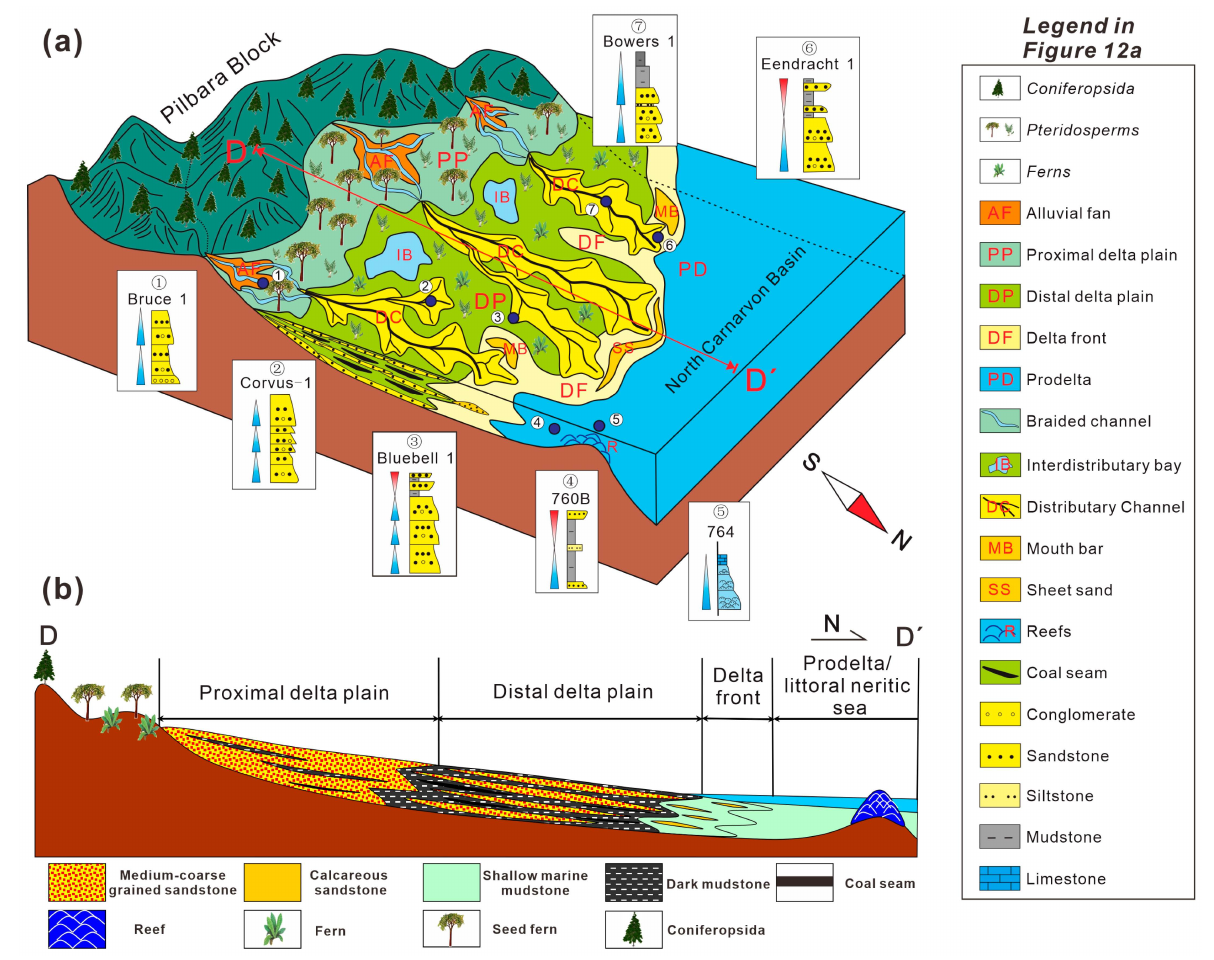
Figure 12. ( a ) The three-dimensional dispersal pattern model of the typical shallow-water coal- bearing delta of the Mungaroo Formation in the NCB. ( b ) Two-dimensional conceptual profile of the distribution pattern of the terrigenous organic matter in the Mungaroo deltaic system, indicating the facies dispersal pattern and lithologies’ distribution and combination. See Figure 12a for the position of the profile D–D (cid:48)